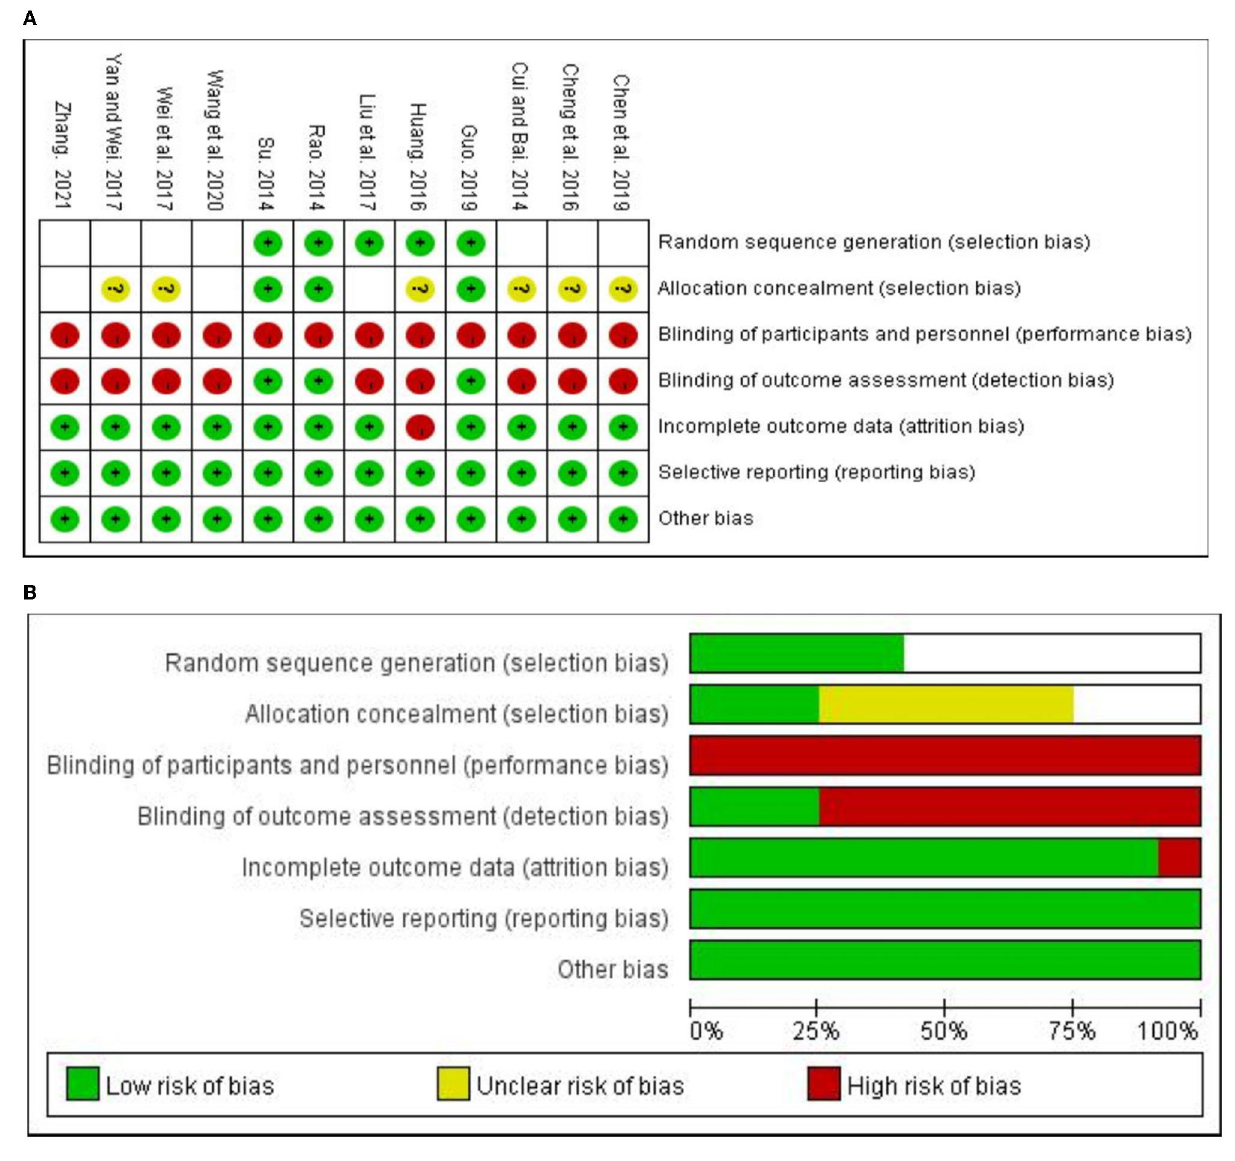
FIGURE 2 | Risk of bias summary (A) and graph (B)